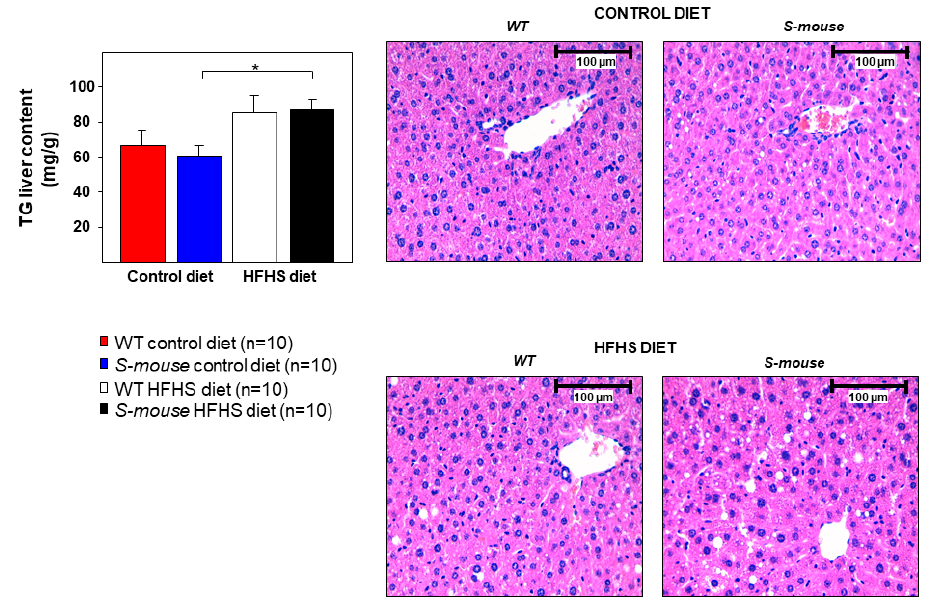
Figure 4. Liver characterisation in WT and S-mice fed high-fat, high-sucrose or control diet for 16 weeks. Analysis of triglyceride content in liver in all mice groups. Images of hematoxylin-eosin stained sections showing lipid droplets (20× magnification). Data are presented as mean ± SEM. Statistical analysis was performed using one-way ANOVA. * p ≤ 0.05 . HFHS high-fat, high-sucrose, TG triglyceride.